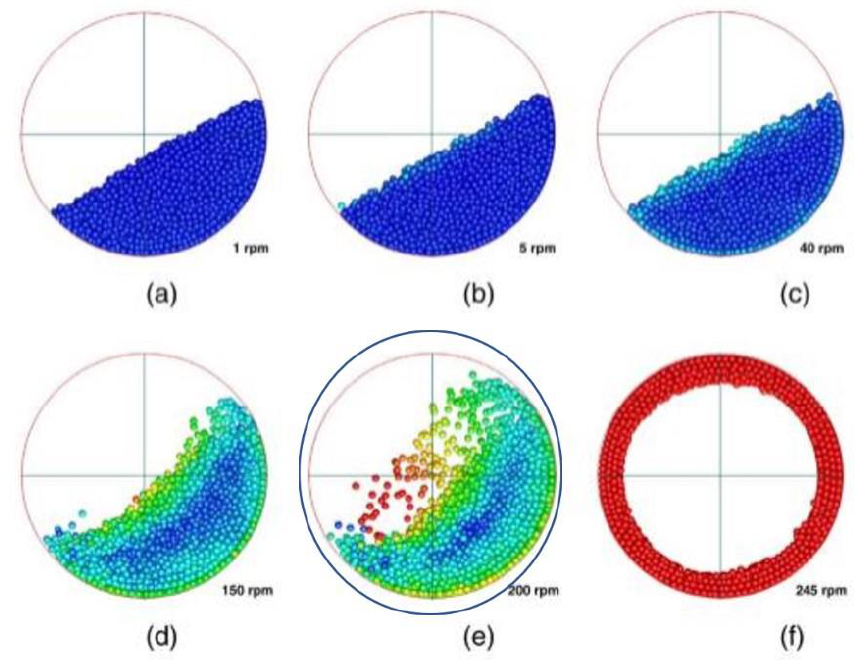
Figure 5. Image showing various flow regimes (( a ) slumping, ( b ) slumping-rolling, ( c ) rolling, ( d ) cascading, ( e ) cataracting, ( f ) centrifuging) [100]. It is hypothesized that the AE sensor would be placed on the structure of the mixer itself.